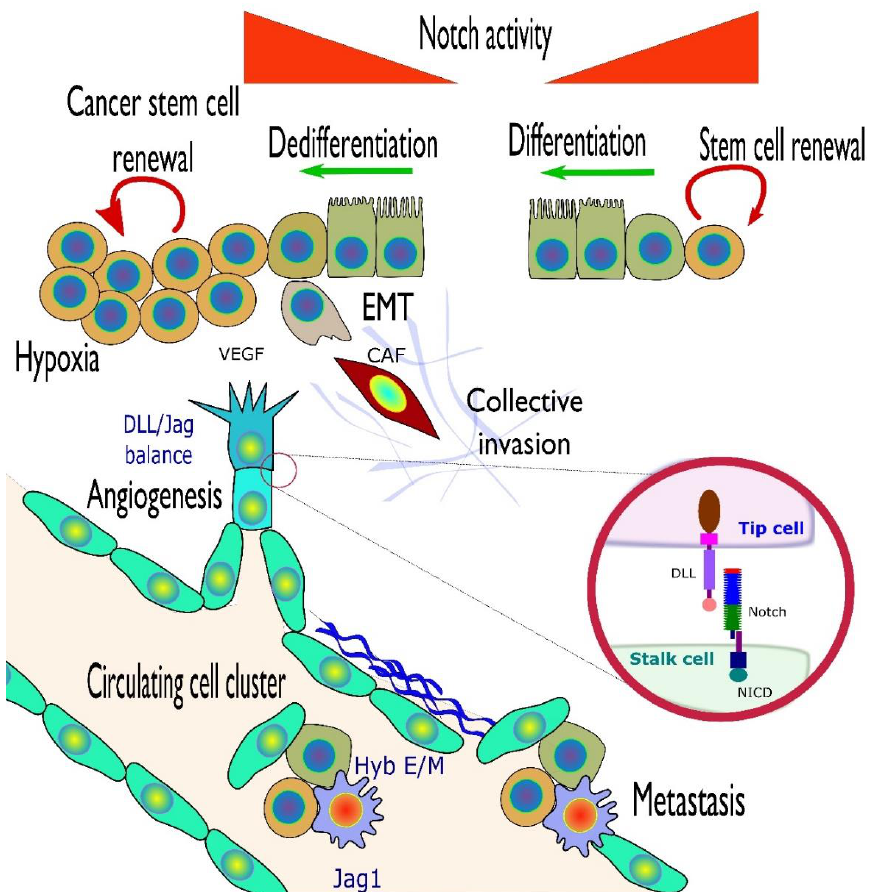
Figure 5. Notch activity in different contexts, exemplified here within the context of epithelial tissues and cells (olive-green cells, partly with brush border). Notch activity is important in stem cell renewal and differentiation (top-right). This is hijacked in some cancer cell types to maintain stem-like features such as unlimited proliferation and acquiring resistance to radio/chemotherapy (cells orange-brown color), in others to gain a mesenchymal phenotype (gray cells) that can resemble the phenotype of cancer-associated fibroblasts (CAFs, dark brown) and may result in collective invasion, characteristic for epithelial cells. As tumors grow, they may become increasingly hypoxic, which triggers neo-angiogenesis. The vasculature (endothelial cells, turquoise) is positive for Notch receptors and ligands, thus the interaction of the vasculature with tumor cells is likely a factor in invasiveness. One of the most striking features of Notch signaling, via Jag1 and hyb-E/M (hybrid epithelial-to-mesenchymal transition), is its supportive role in circulating clusters of tumor cells that have particularly high metastatic potential (olive colored, rounded cells), partnering also with immune cells (stellate, blue cells with red nuclei). The inset shows the ligand–receptor activation between 2 cells. Gene symbols explained in the